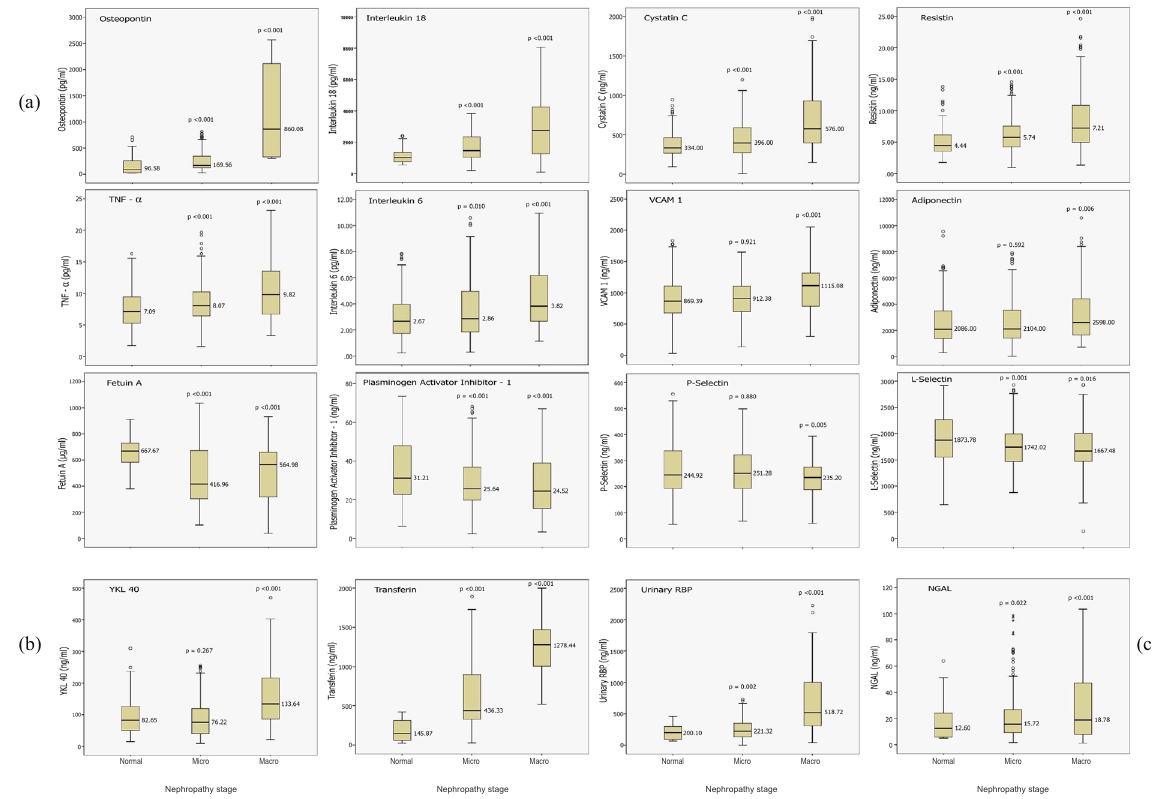
Figure 1. ( a ) Box plot values for the significant serum nephron-biomarkers according to different nephropathy stag. ( b ) Box plot values for the significant plasma nephron-biomarkers according to different nephropathy stages. ( c ) Box plot values for the significant urinary nephron-biomarkers according to different nephropathy stages. * P value compared with subjects with normal albumin